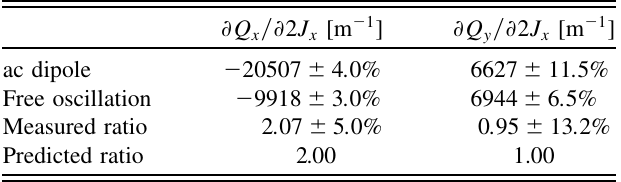
TABLE I. Octupolar term given by the fit results ac dipole and single kick data at injection energy. The errors given in this table represent the fit errors. The predicted ratio represents theoretical expectations for octupolar